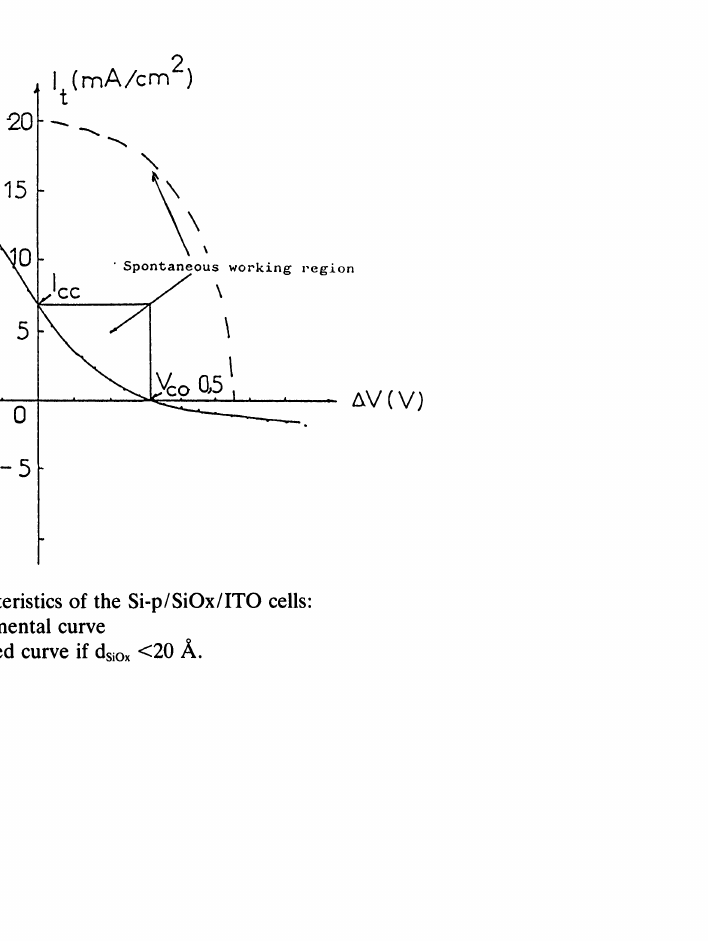
FIGURE 12 I-V Characteristics of the Si-p/SiOx/ITO cells: (1) Experimental curve (2) Expected curve if dsiox